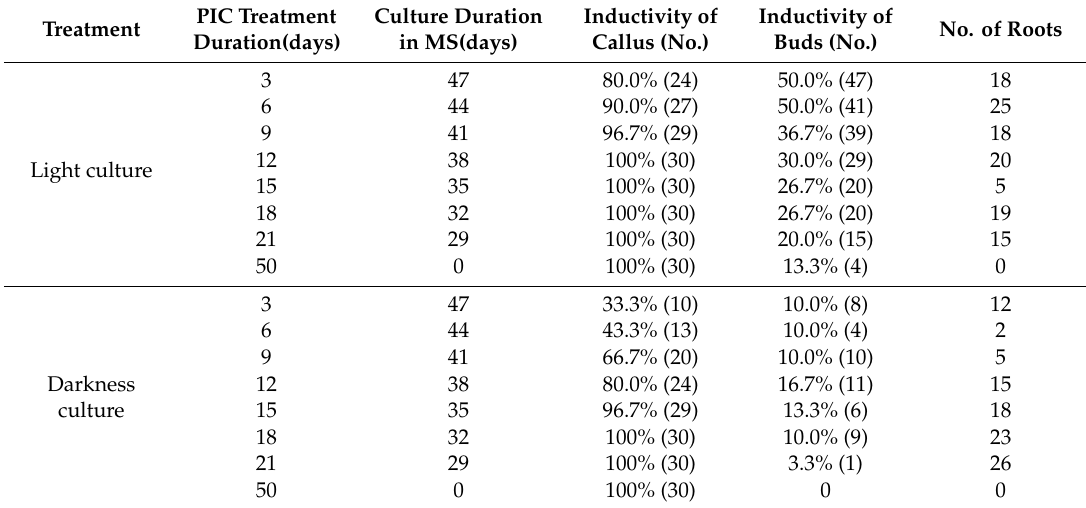
Table 1. The e ff ects of picloram (PIC) and light on somatic embryo induction (50 days).